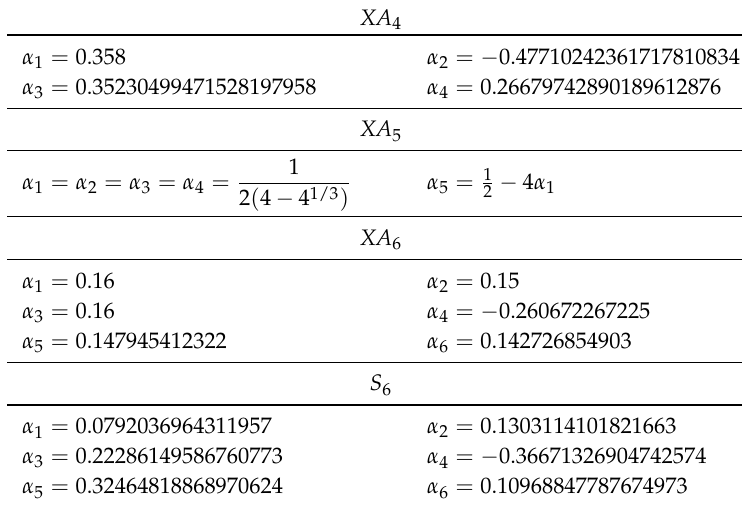
Table 2. Fourth-order composition methods XA s with s stages minimizing E 1 and E 2 . Method S 6 corresponds to the splitting method of ([23] Table 2) expressed as a composition